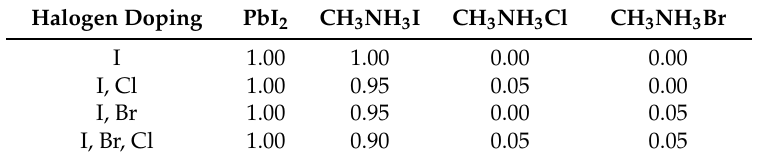
Table 1. Recipe of perovskite precursor solution varied with halogen doping at molar ratio.